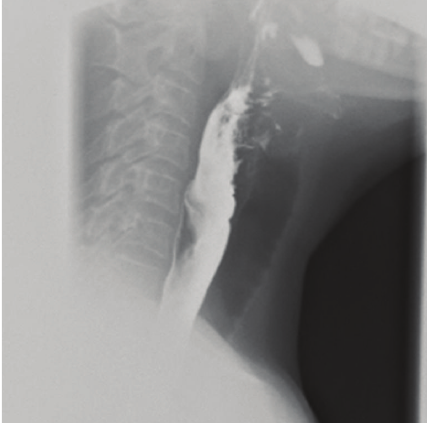
Figure 3: Esophagogram shows a 2 cm oval wall irregularity on the back slope of the distal cervical